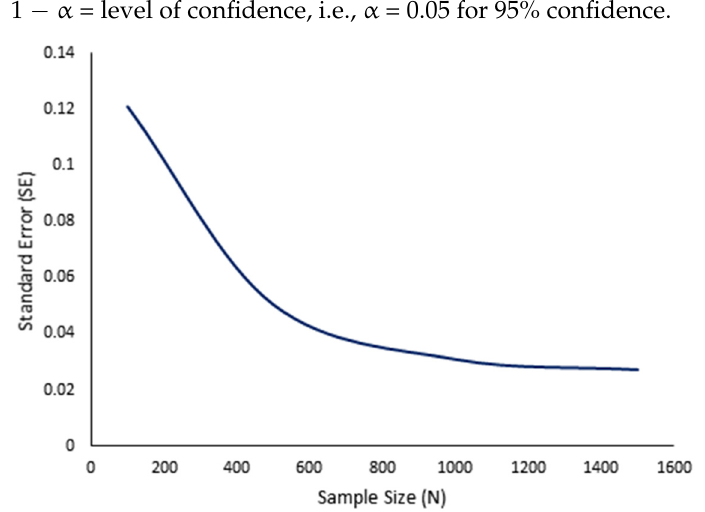
Figure 9. Standard Error (SE) relative to sample size (N) for Hs.